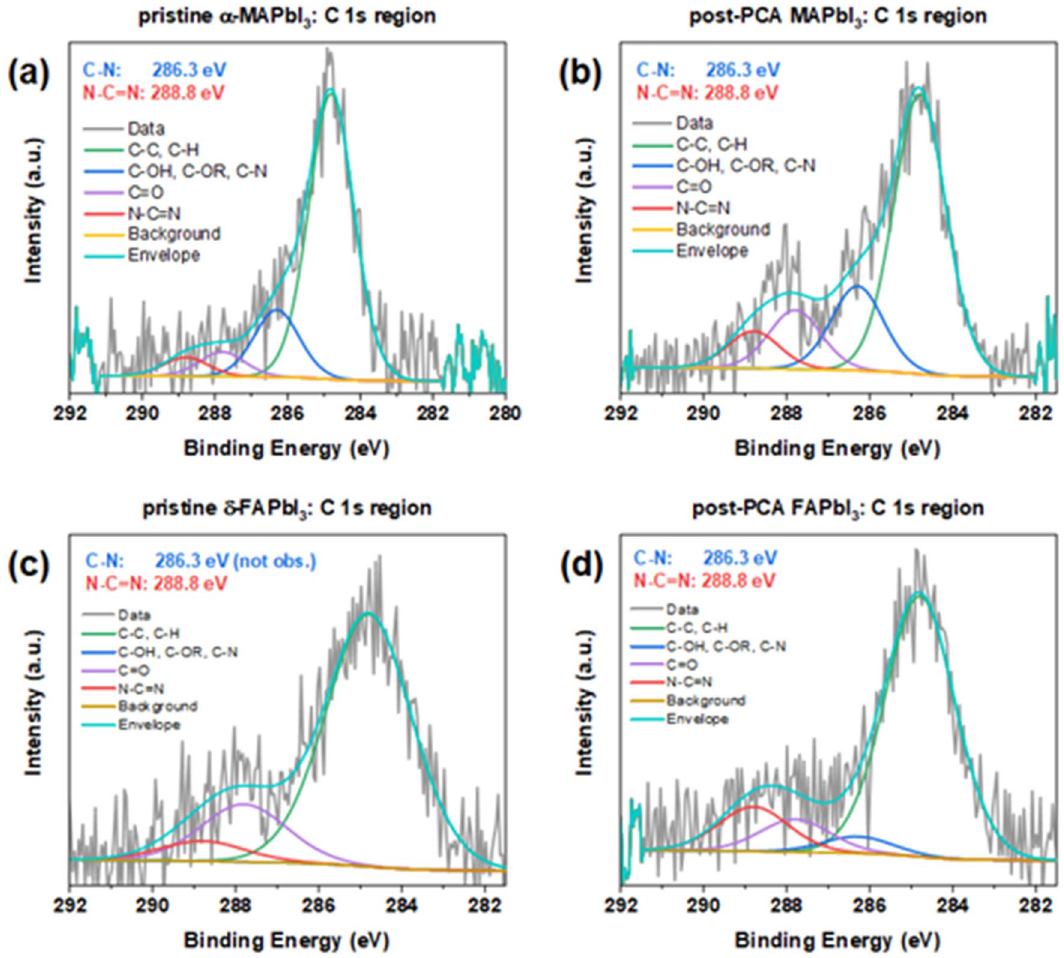
Figure 4. High-resolution scans of the probed C 1 s regions of ( a ) pristine α-MAPbI 3 , ( b ) post-PCA MAPbI 3 after 60 h annealing, ( c ) pristine δ-FAPbI 3 , ( d ) post-PCA FAPbI 3 after 60 h